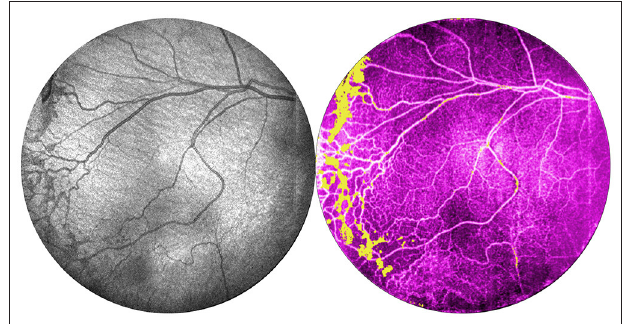
FIGURE 6 | Comparison of OCT and OCTA images of retinal vasculature. This is the same patient as Figure 1 (24 weeks gestation, 770g) seen at 35 weeks gestation. From left: OCT en face image, and corresponding OCTA en face image with flow signal in the vitreous shown in